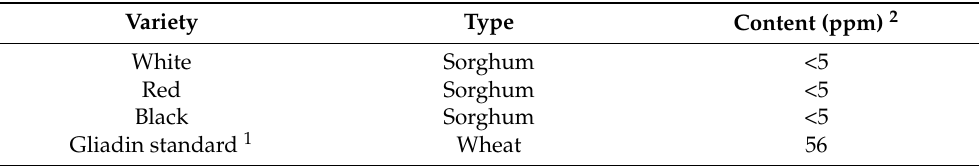
Table 5. Measurement of gliadin (as ppm) in flours by using sandwich R5 enzyme-linked immunosor- bent assay (ELISA). Variety Type Content (ppm) 2 White Sorghum <5 Red Sorghum <5 Black Sorghum <5 Gliadin standard 1 Wheat